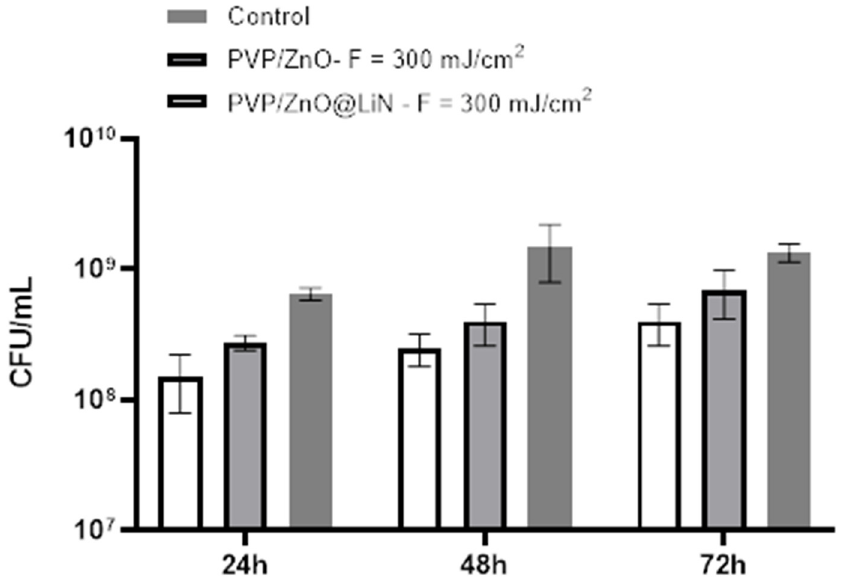
Figure 19. Evaluation of microbial biofilm development 24, 48, and 72 h after incubation with P. aeruginosa in the presence and absence of PVP/ZnO@LiN thin coatings.